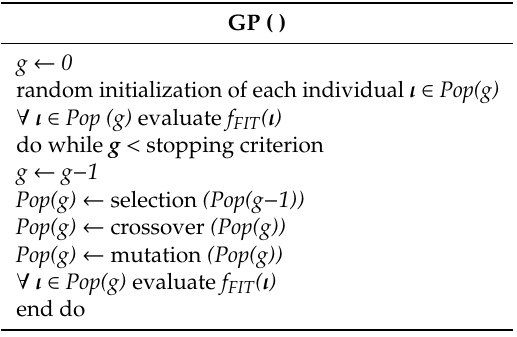
Table 1. Algorithm for GP to forecast of the scale parameter.